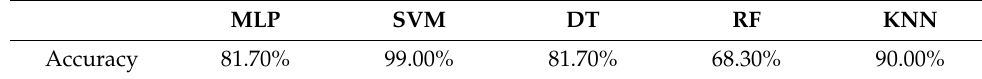
Table 5. Classification results for Dataset 02 (COPD/control).